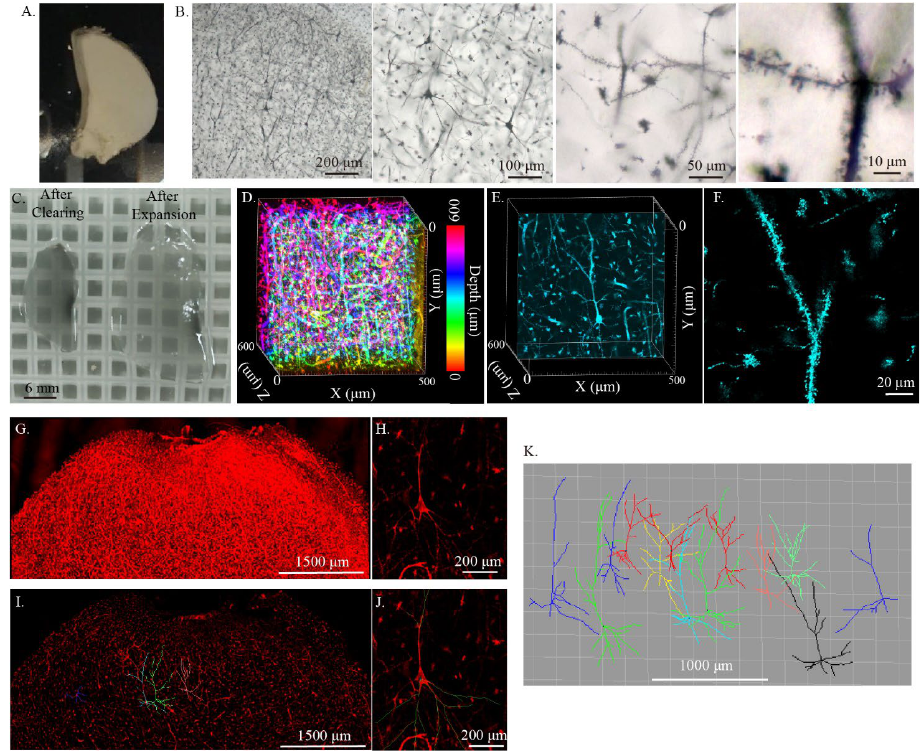
Figure 7. Three-dimensional imaging and reconstruction of modified MAP cleared Golgi-Cox-stained human brain tissue. ( A ) Whole-mount Golgi-Cox staining of human brain tissue. ( B ) Photo- micrographs illustrating the fine neural structure, such as neural cell bodies, fibers, and dendritic spine labeled using Golgi-Cox staining. ( C ) Golgi-Cox-stained human brain tissue that was 300 μm thick (about 600 μm thick after clearing) after clearing and expansion. ( D ) Three-dimensional imag- ing of cleared Golgi-Cox-stained human brain tissue with confocal reflective mode and depth color coding. ( E ) Sectional image from ( D ) showing the fine neuronal morphology. ( F ) The dendritic spine in human brain tissue. The tissues were labeled using Golgi-Cox stain and imaged with confocal reflective mode. ( G ) Maximum intensity projection image showing larger volume imaging of the cleared Golgi-Cox-stained human brain tissue. ( H ) Sectional image from ( G ) showing an individual neuron. ( I ) Sectional image from ( G ) showing the reconstruction of neuronal morphology in human brain tissue. ( J ) Illustration of the reconstruction of the neuron morphology in ( H ). ( K ) The